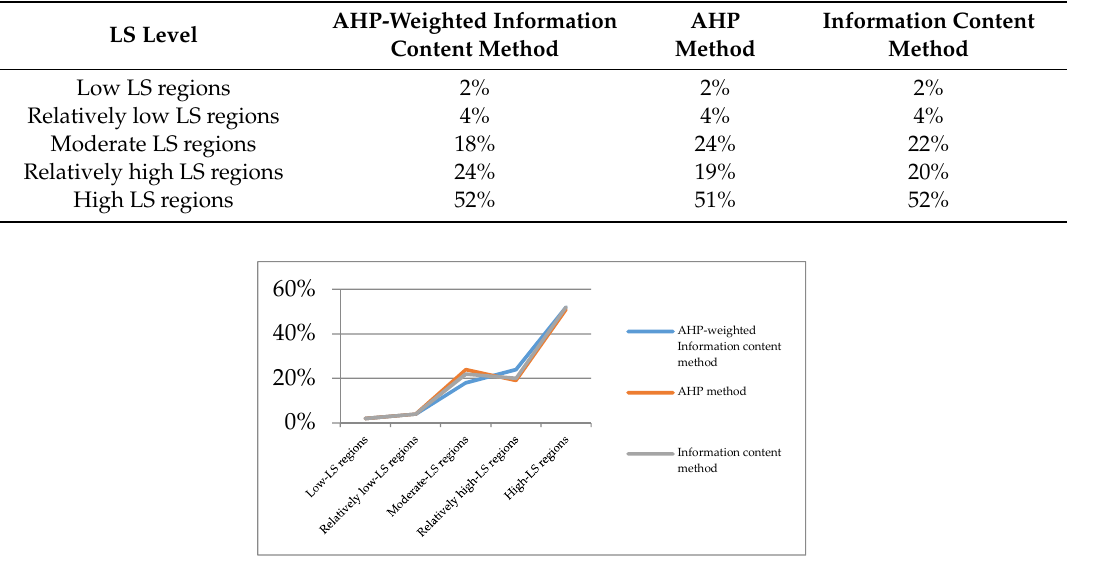
Figure 7. Analysis of the proportion of landslide sites in regions of different LS levels determined using the three methods.